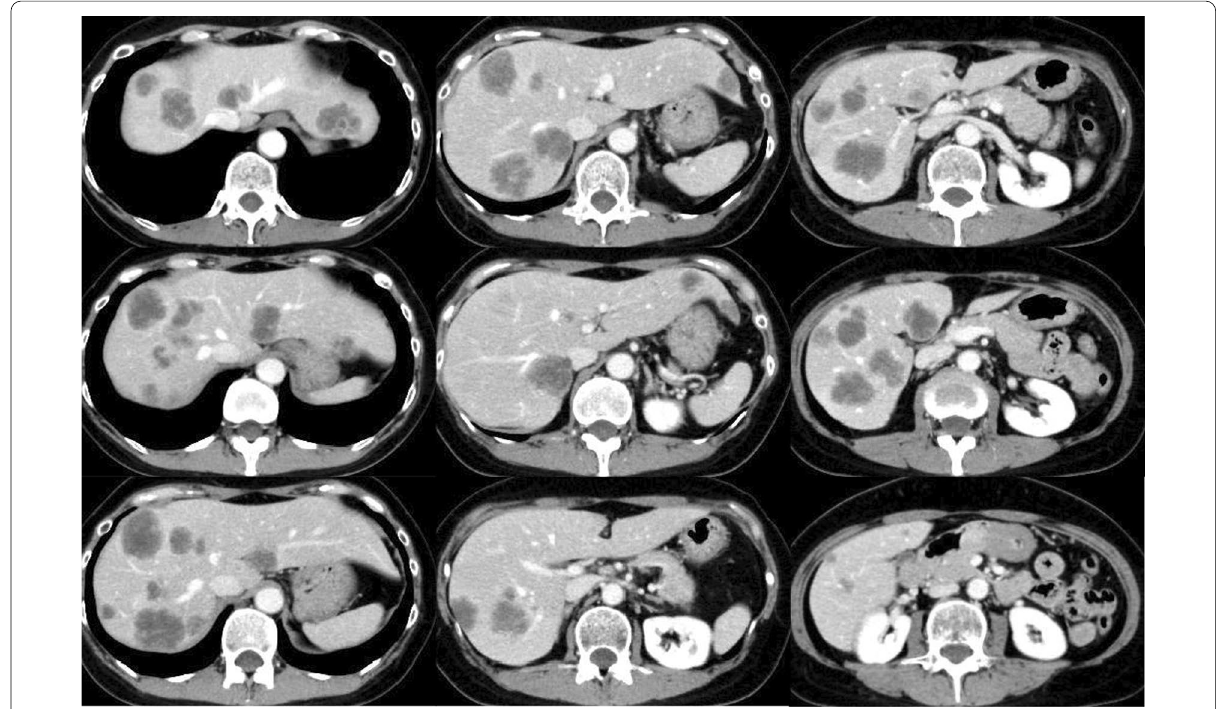
Fig. 1 Computed tomographic findings before chemotherapy. Multiple metastases diffusely involve the